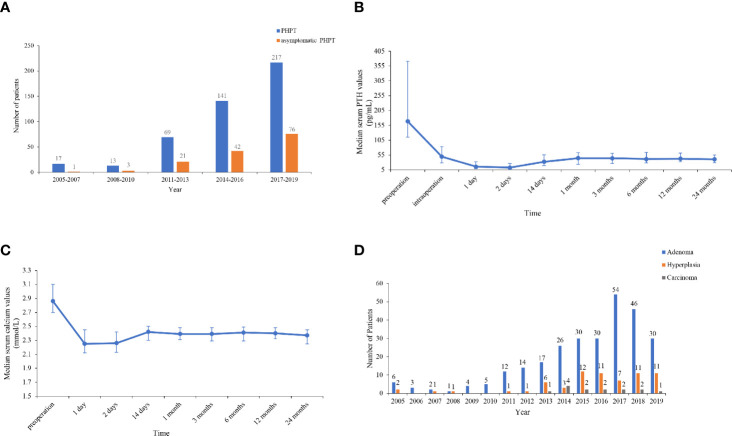

(A) Number of total and asymptomatic patients in 2005–2019. The number of patients with total primary hyperparathyroidism (PHPT) markedly increased by 11.8 times from 2005–2007 to 2017–2019, and the proportion of asymptomatic patients increased by 5 times from 2005–2007 to 2017–2019. (B, C) Trends of serum parathyroid hormone (PTH) and calcium levels pre- and intraoperatively and within 24 months after parathyroidectomy. Serum PTH and calcium levels decreased to the lower limit of normal 1–2 days after resection, then increased to a peak of normal range at 1 month and then reached a rather sustainable plateau at 6–24 months. (D) Number of patients with parathyroid adenoma, hyperplasia, and carcinoma in 2005–2019. The number and proportion of patients with parathyroid adenoma, hyperplasia and carcinoma were 280 (77.6%), 67 (18.6%), and 14 (3.9%), respectively.